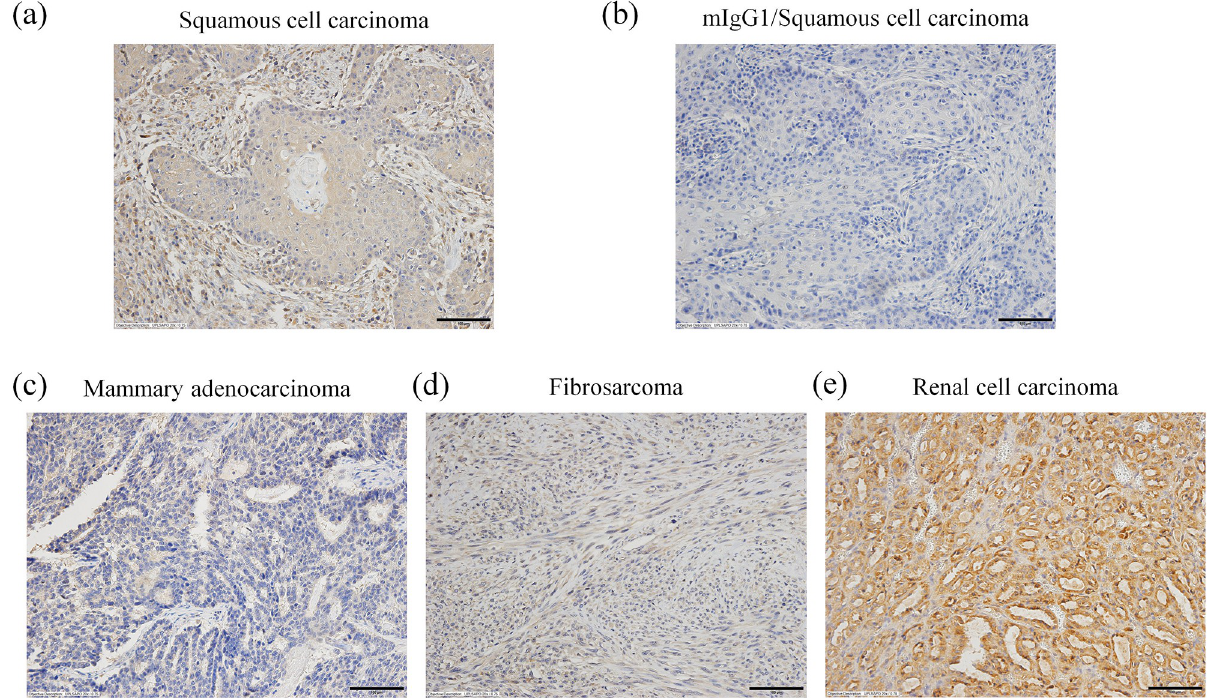
Fig 5. PD-L1 immunohistochemistry (IHC) for feline malignant tumors. (a) IHC staining of feline squamous cell carcinoma using anti-feline PD-L1 monoclonal antibody CL1Mab-7. (b) IHC staining of feline squamous cell carcinoma using mIgG 1 . (c) CL1Mab-7 IHC staining of feline mammary adenocarcinoma. (d) CL1Mab-7 IHC staining of feline fibrosarcoma. (e) CL1Mab-7 IHC staining of feline renal cell carcinoma. Scale bar, 100 μ m.